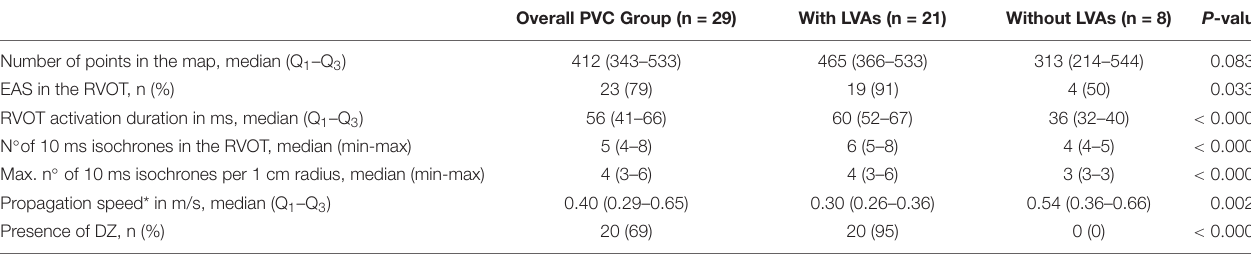
TABLE 3 | Sinus rhythm activation data in the PVC group according to the presence of LVAs. Overall PVC Group (n = 29) With LVAs (n = 21) Without LVAs (n = 8) P -value